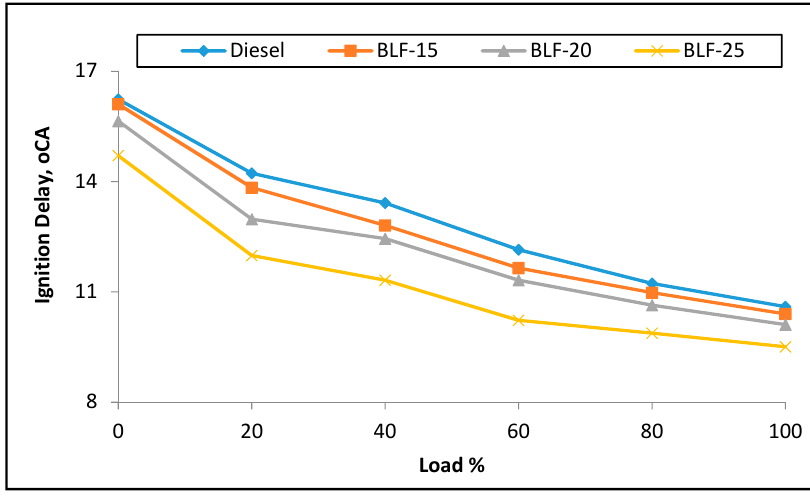
Figure 4. Variations of ignition delay vs. engine load percent.